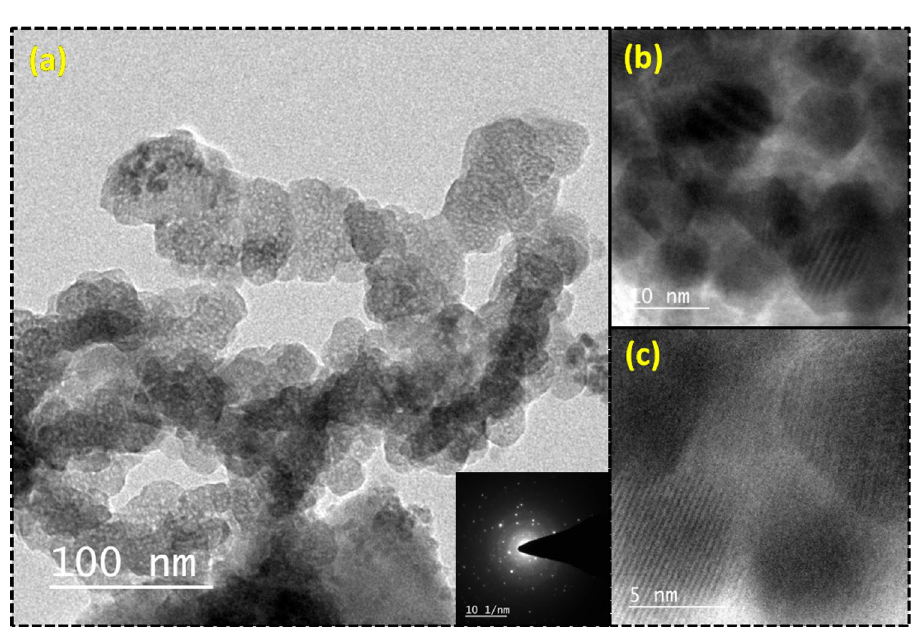
Figure 4. TEM micrograph of Fe 3 O 4 /α-F 2 O 3 nanocomposite [inset shows SAED pattern] ( a ), HE-TEM micrograph at two different magnifications ( b , c